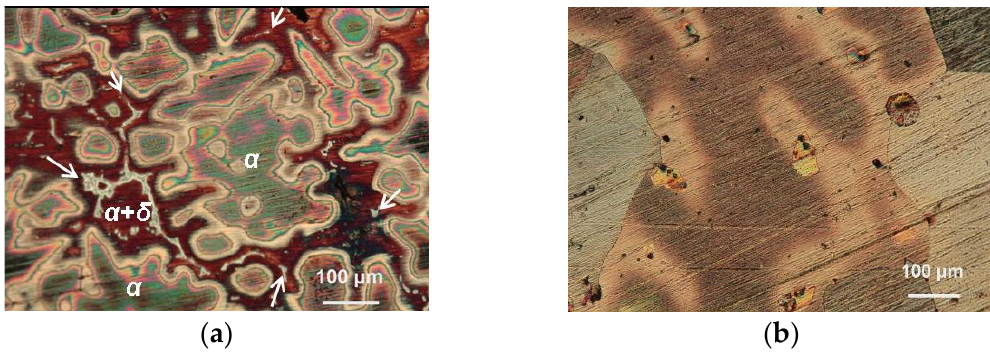
Figure 2. Optical microscope images (×100) of: ( a ) TB (the arrows indicate the islets of δ phase inside the α + δ eutectoid); ( b ) ZB archaeometallurgical alloy after colour etching by Klemm II reagent, revealing the dendritic microstructure of the as-cast surfaces.